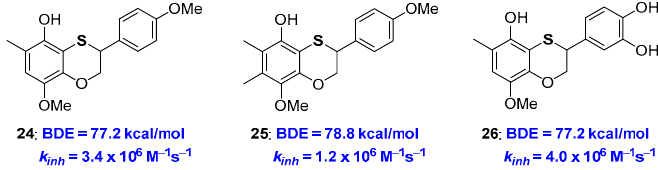
Figure 8. Optimized benzoxathiines phenolic chain breaking antioxidants 24–26.